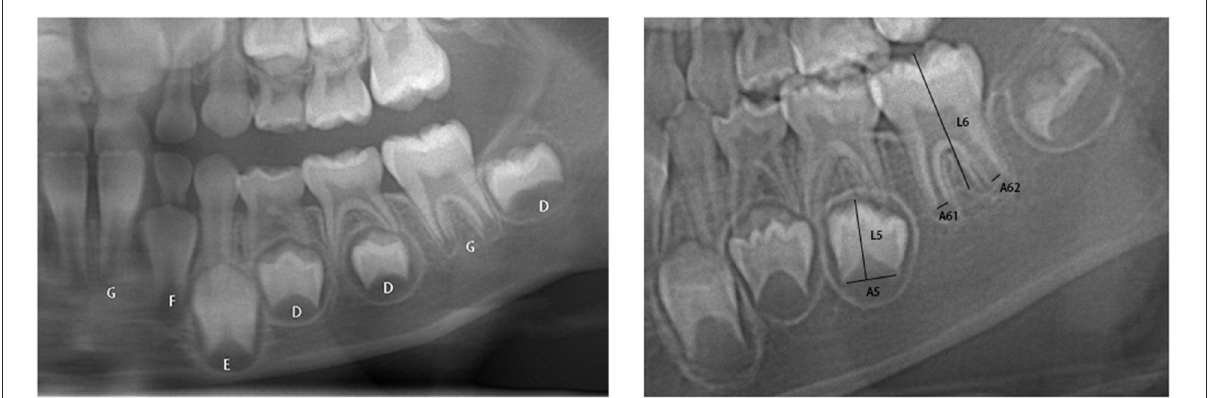
FIGURE1 (Left) Schematic representation of the developmental assessment of seven molars according to the Demirjian method (the letters represent the stages of the Demirjian tooth age inference method). (Right) Schematic representation of the measurement of single-rooted and double-rooted teeth according[[Inline Image]] to the Cameriere